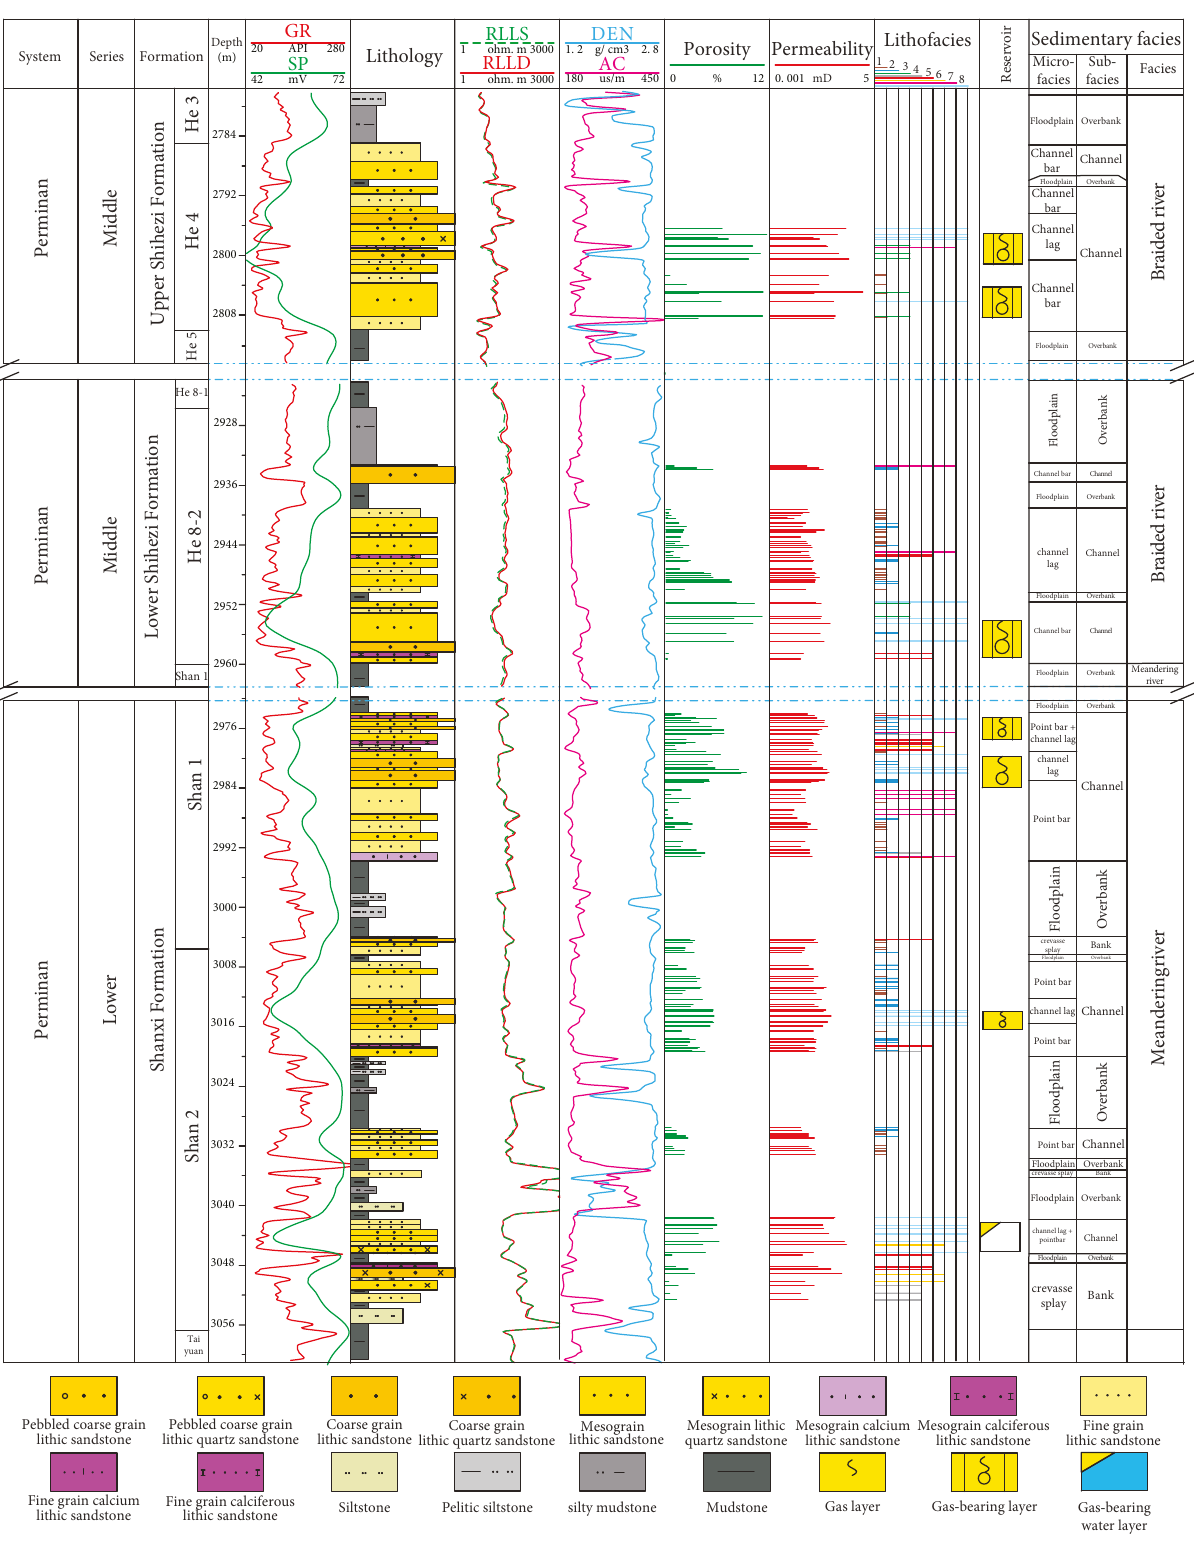
Figure 9: Lithology, well log, reservoir quality, and sedimentary facies synthetic histogram of well